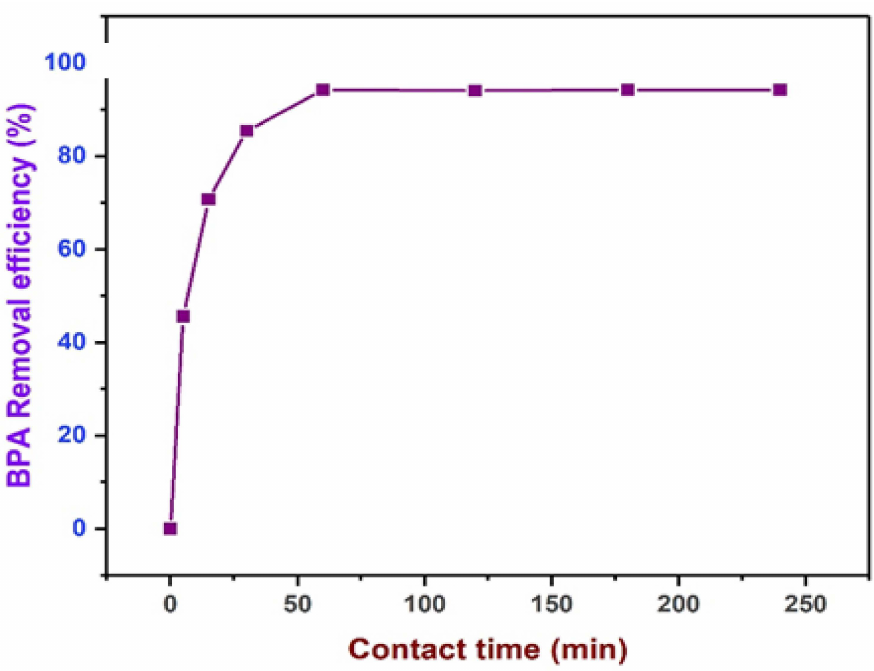
Figure 11. Effects of contact time (20–240 min) on the per cent removal of BPA, at 0.5 g dosage, BPA concentration 20 ppm, temperature (293.15 K), and pH